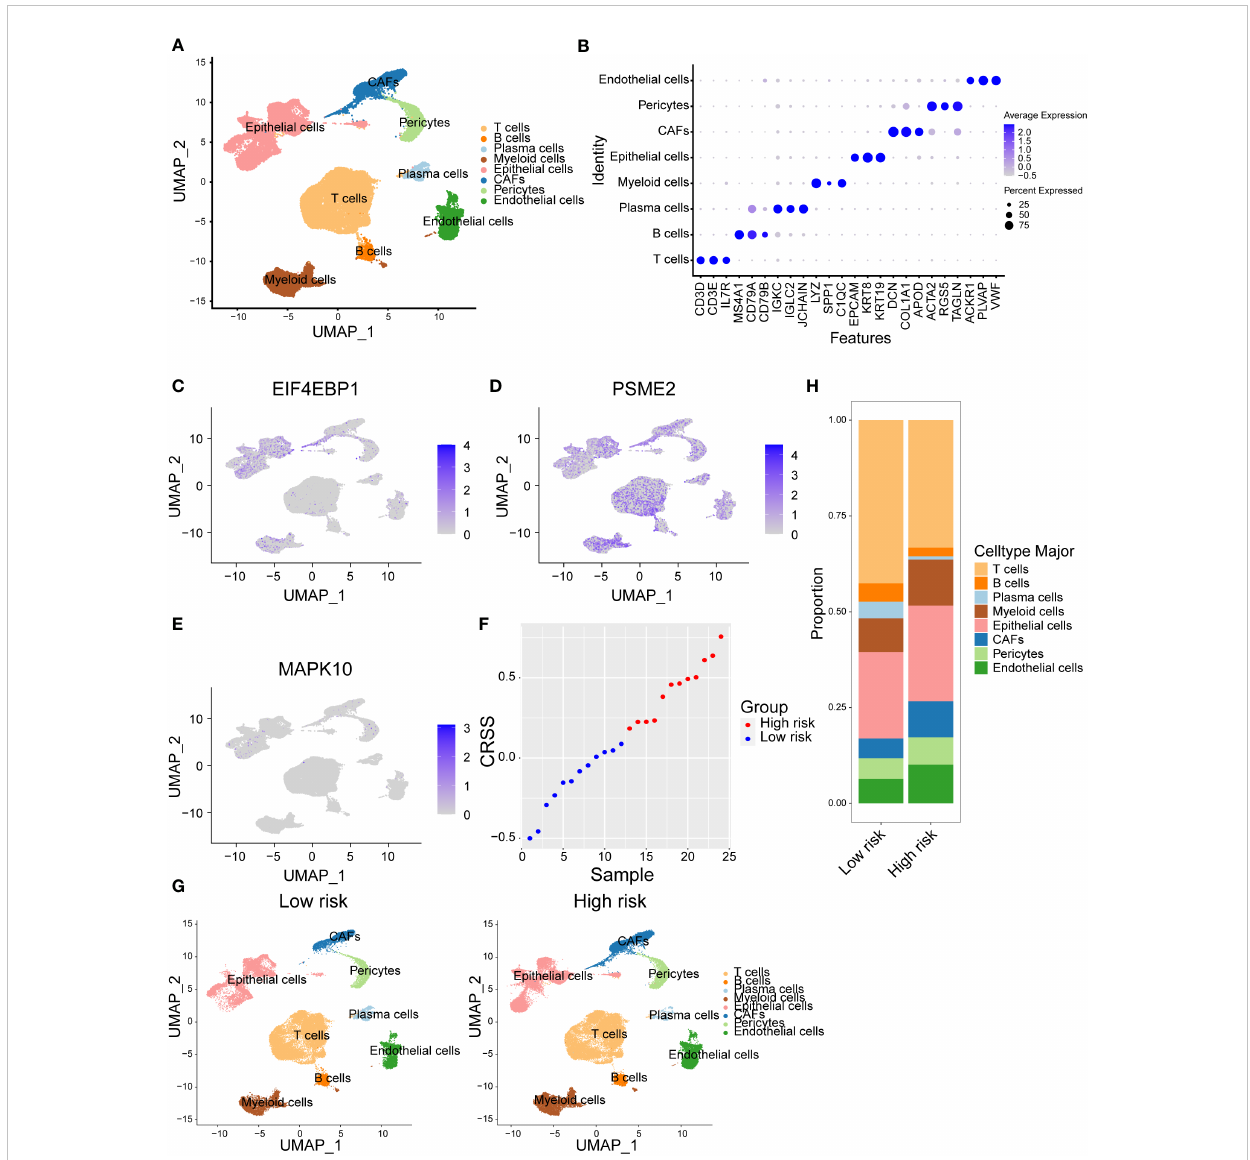
FIGURE 6 Distinct cellular composition of high/low-risk breast cancer patients at single-cell resolution. (A) Cells were clustered into eight types via tSNE dimensionality reduction algorithm, each color represented the annotated phenotype of each cluster. (B) Dot plot of the top three marker genes expression of each cluster. (C – E) Expression of three centrosome-related prognostic genes in each cluster. (F) CRSS of 24 samples from breast cancer single cell dataset GSE176078. (G) eight cell clusters in the high/low-risk groups were identi fi ed via tSNE dimensionality reduction algorithm. (H) The proportion of cells in high/low-risk groups of breast cancer single cell dataset